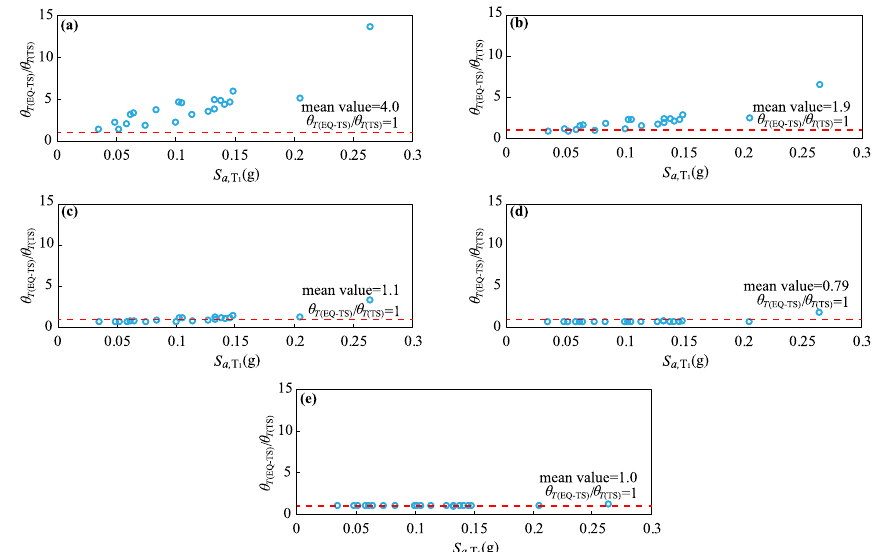
Fig. 13 Ratio of transverse pier drift with respect to the S a , T d 8 m and e 9